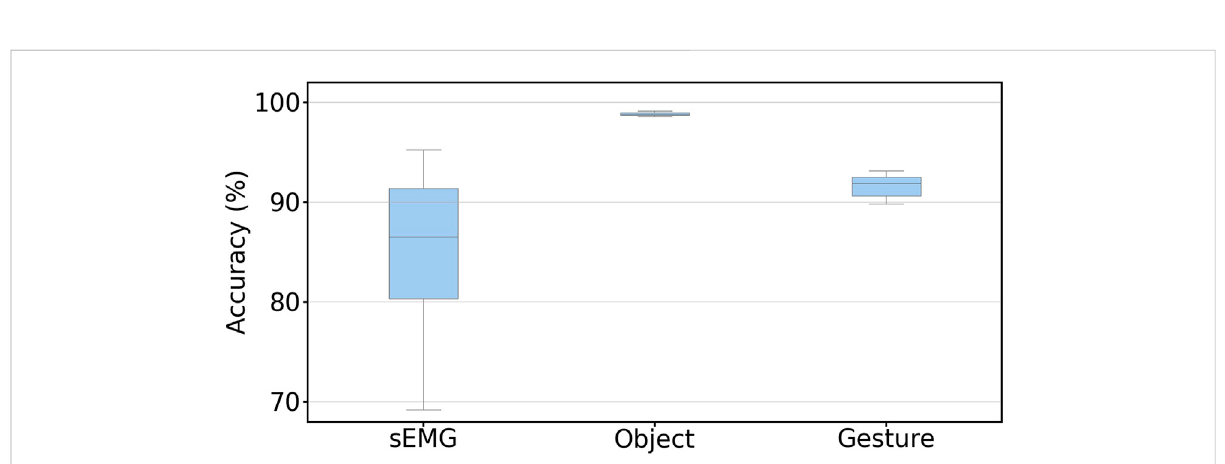
FIGURE 6 Meanclassi fi cationaccuracyoftheobjectandgestureduringthesweetperiodamong30subjects.ThesEMGresultisfromthebeststrategywe achieved in our last research which also utilized the sweet period for sEMG signals. The values for sEMG, and object and gesture classi fi cation accuracies are 85.50, 98.81, and 91.59%, respectively. The result is calculated with leave-one-repetition-out